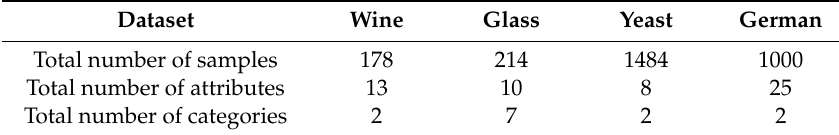
Figure 3. Comparison of test results on different UCI datasets.